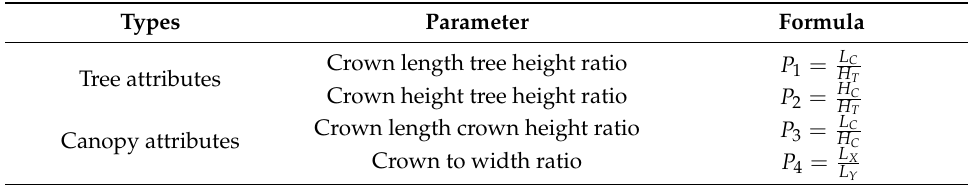
Table 2. Combined attribute parameters.